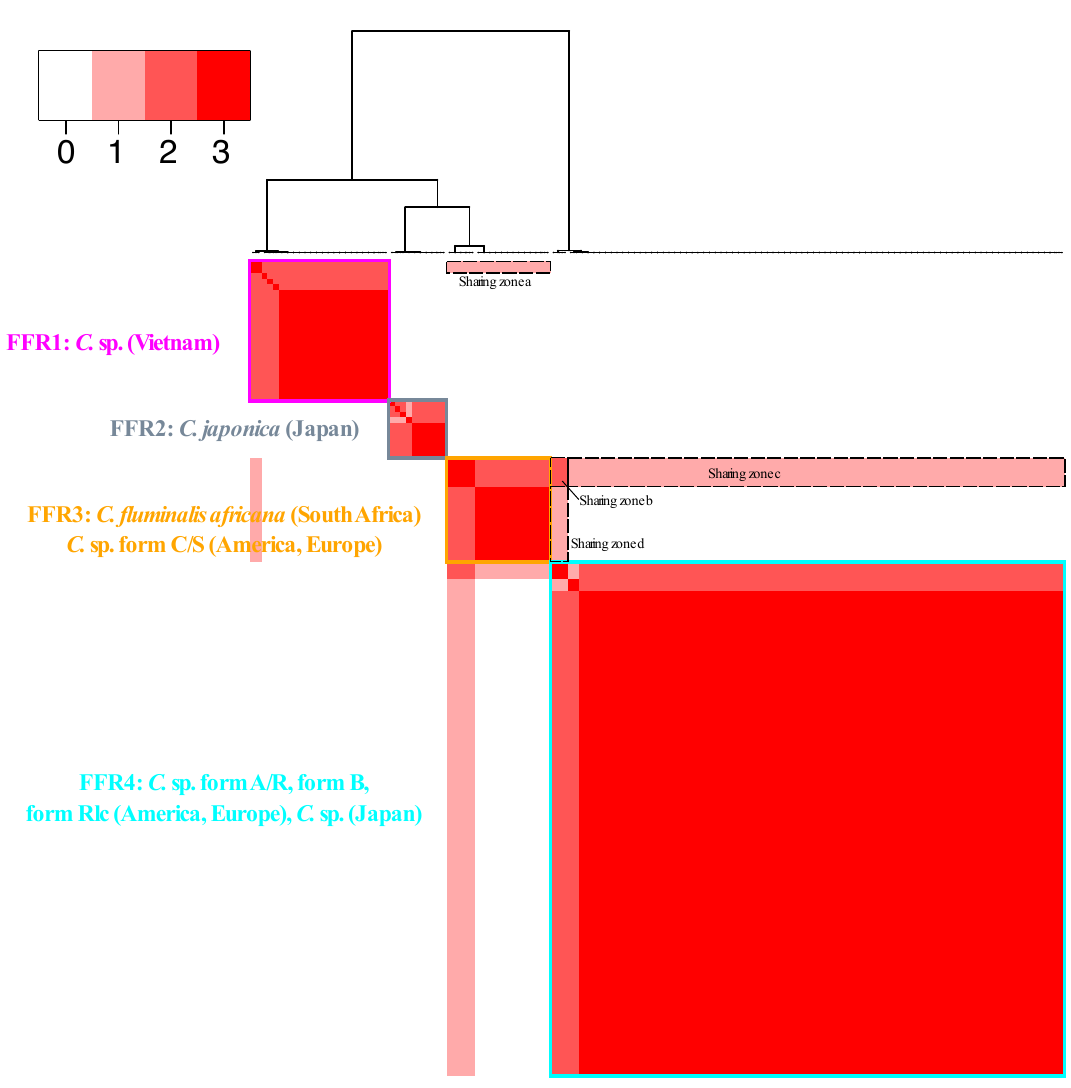
Figure 3: Conspecificity matrix based on alleles shared between individuals across the three nuclear markers (28S, alpha-amylase, ATPS). In this matrix, the axes correspond to the individuals (n = 141) and the red signal corresponds to the number of times individuals were found within the same allelic pool (score from 0 to 3 for all tested markers). Based on the dendrogram (Ward clustering), four FFRs were defined. All individuals are represented using the same color scheme as used for haplowebs and the haplonet (see Figure 2). Signals of allele sharing between these FFRs, corresponding to introgression events, are framed with dotted lines and labelled with letters from a to d. Zone a corresponds to alleles shared between FFR1 and 3, while zones b, c, and d all correspond to sharing between FFR3 and 4. Individual names and geographic origins are detailed in Table S3. Dendrogram and sharing zones are only represented once for